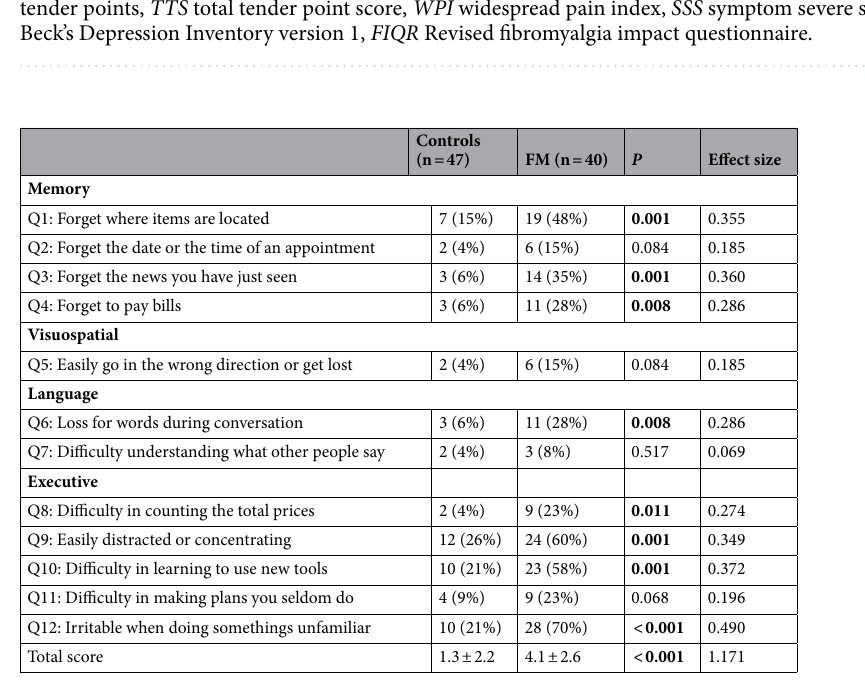
Table 2. Subjective cognitive complaints questionnaire*. Data are mean ± SD, number (%) or % (n/N). Effect sizes are expressed as φ for Q1–Q12 and Cohen’s d for the total score. FM fibromyalgia. *Detailed description of each question is listed in the supplementary table S1.